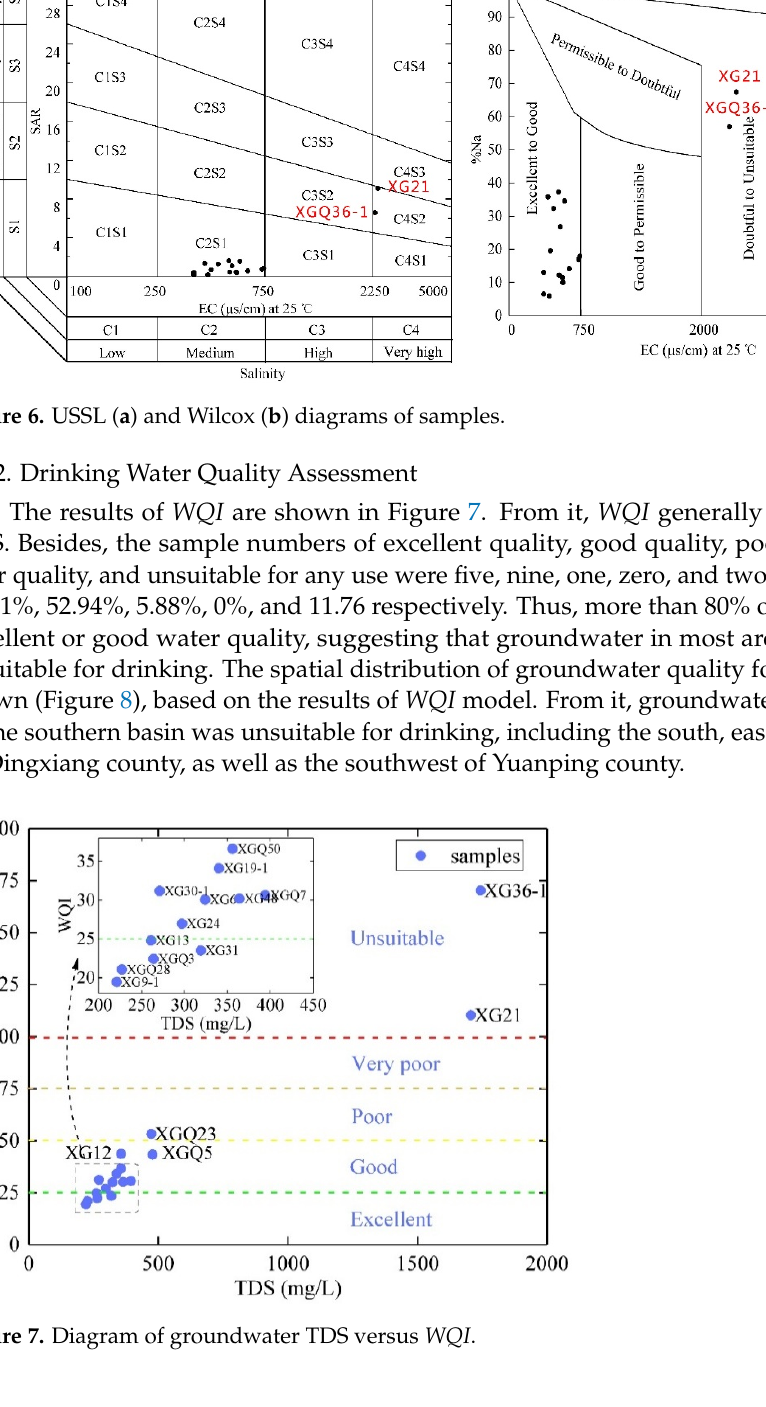
Figure 8. Spatial distribution of water quality index. In summary, the groundwater in most areas of the basin is suitable for irrigation and drinking. However, its quality is extremely poor in some southern parts of the basin, which leads to its unsuitability for any use. The main reason for the poor water quality in some areas is the influence of human activities, especially the emission of industrial pol- lutants, according to the previous analysis. Therefore, government should urge enter- prises to do well in the harmless disposal of industrial pollutants. Meanwhile, the real- time monitoring and warning system of groundwater quality should be established. Moreover, in recent years, the research and application of quality sensors is increasing. This technology is meaningful to improve the accuracy of real-time monitoring and warn- ing of groundwater quality [35,36]. In the end, it is also necessary to formulate a plan to dispose of the contaminated groundwater promptly. Only in this way can groundwater pollution be prevented and controlled.